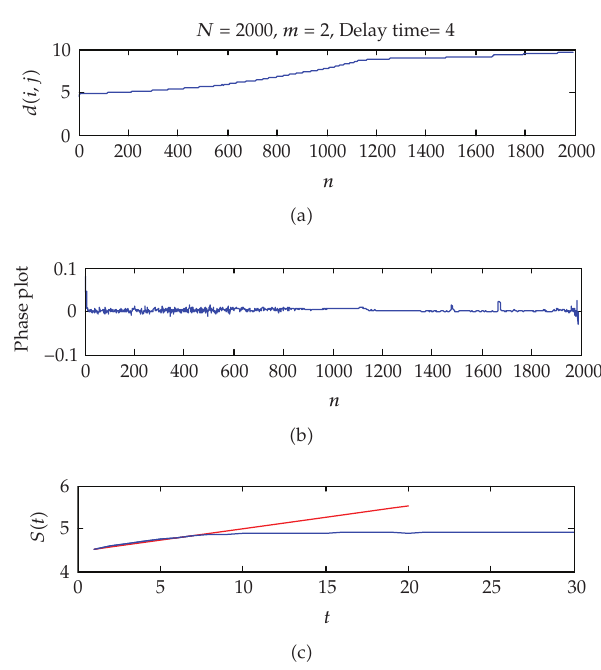
Figure 2: The maximal Lyapunov exponent of retailer’s demand.